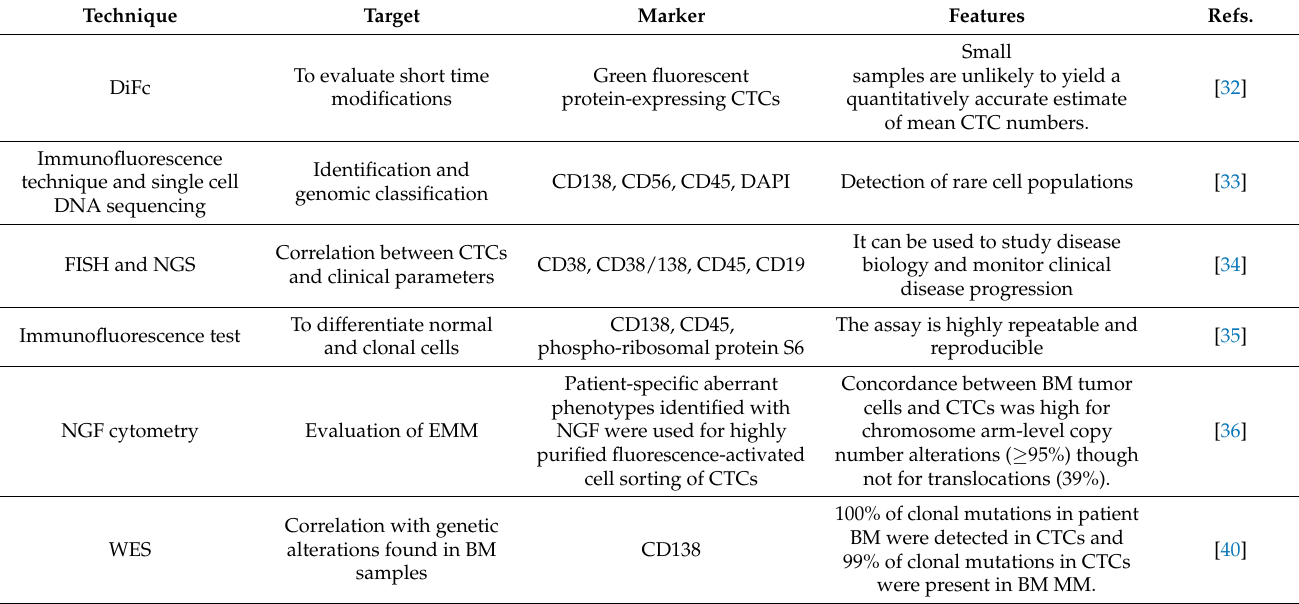
Table 1. Different techniques used in the identification of